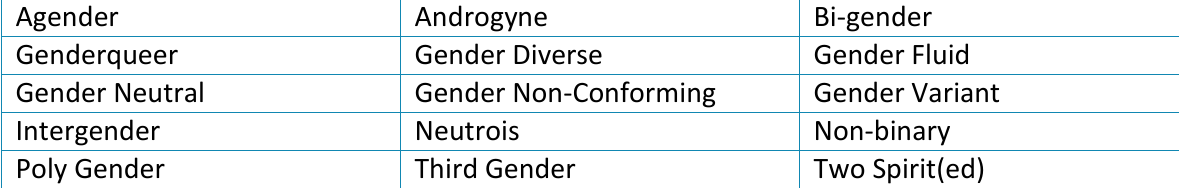
Page | 20 | Words Matter: Guidelines on Using Inclusive Language in the